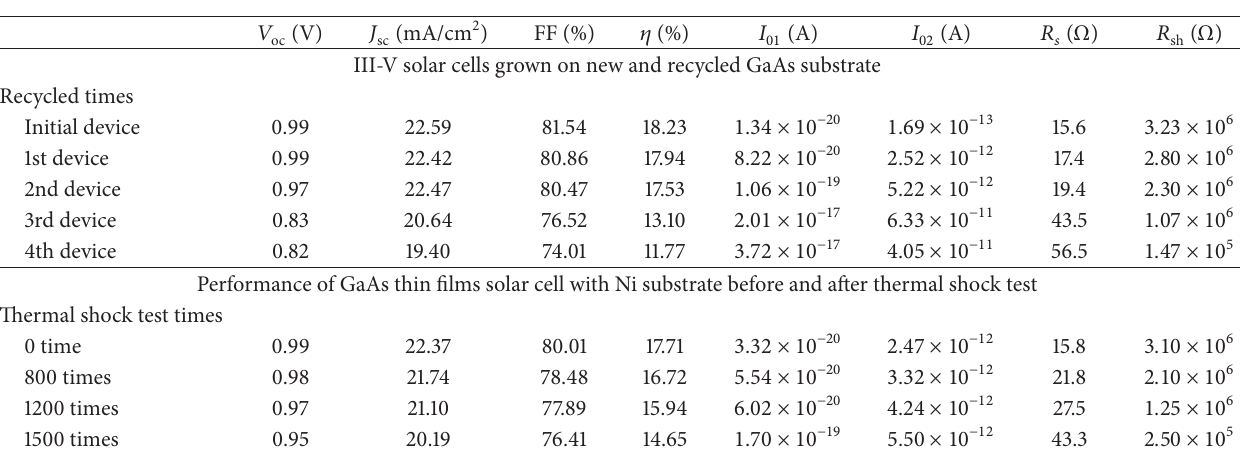
Table 1: Performance of III-V solar cell grown on new/recycled GaAs substrate and GaAs thin film solar cell transferred onto Ni substrate before and after thermal shock test.